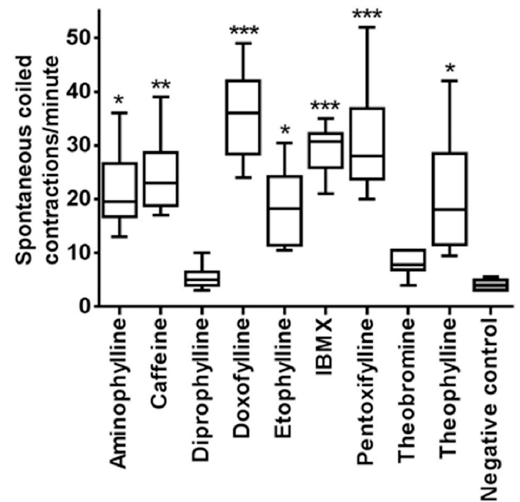
Figure 1. Spontaneous movement quantification at 24 hpf. The following doses of